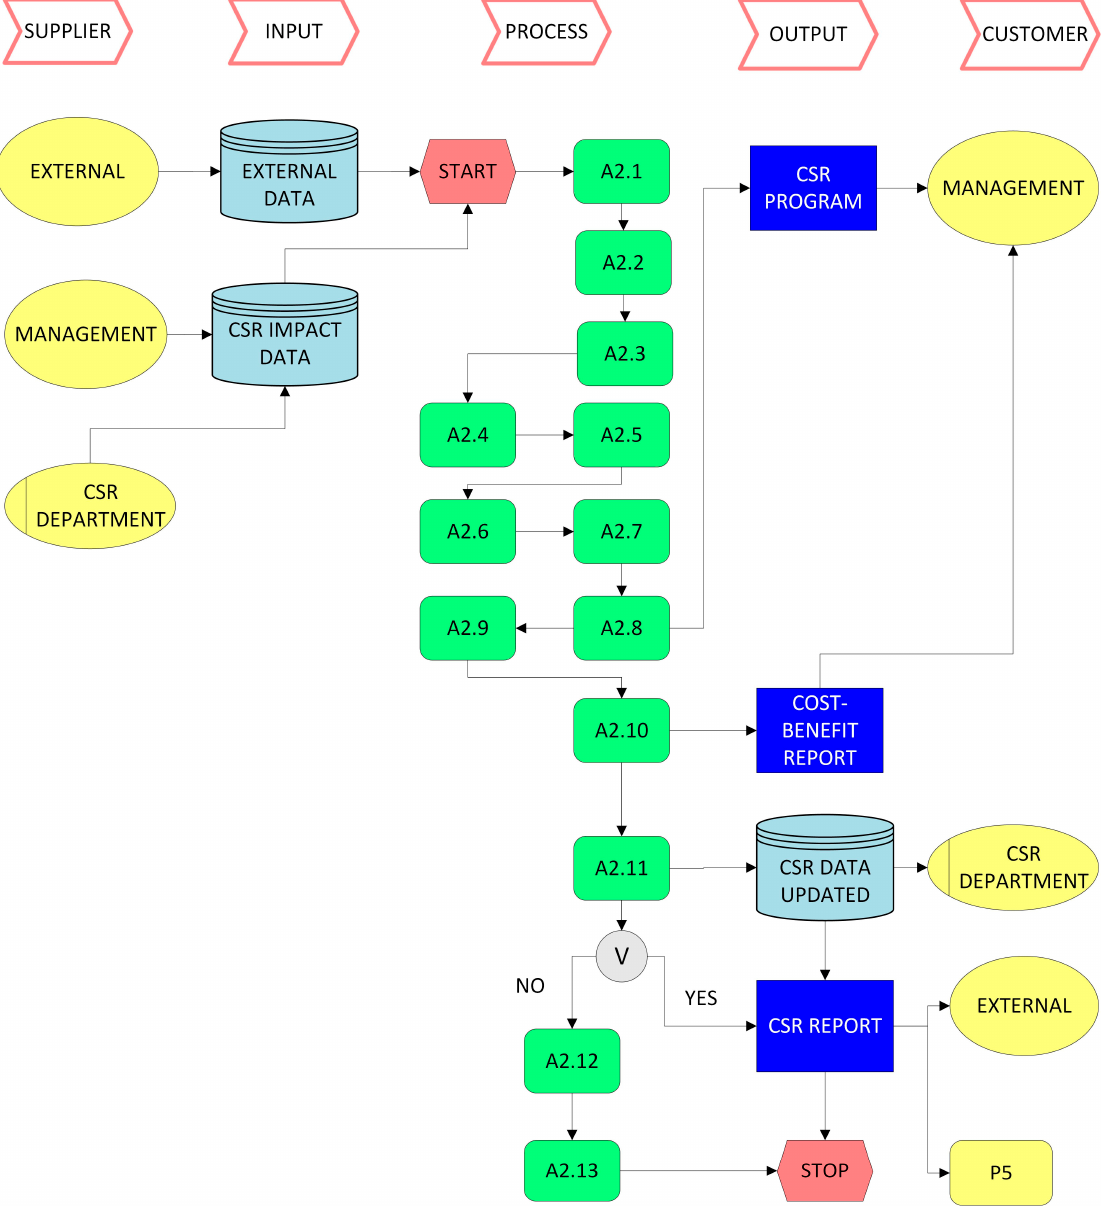
Figure 2. Future state for P2